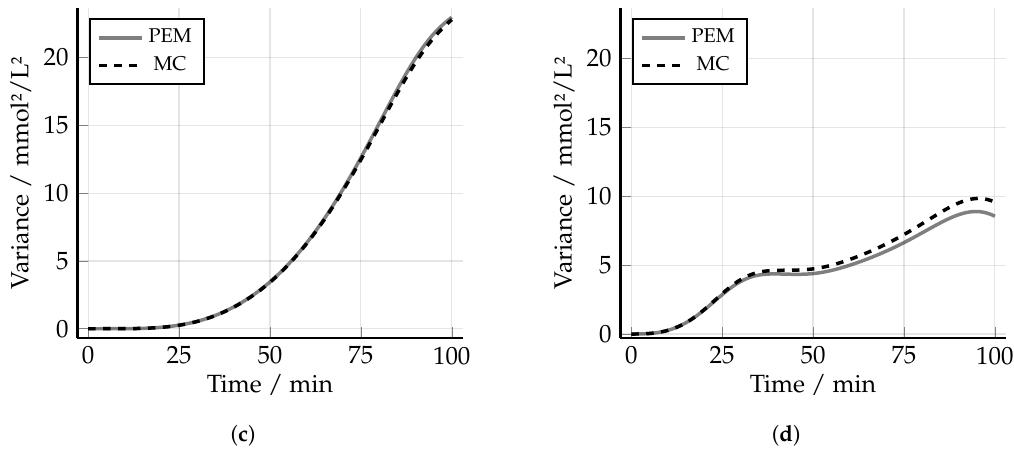
. ( a ) Nominal design, y 1 ; ( b ) Robust design, y 1 ; M 1